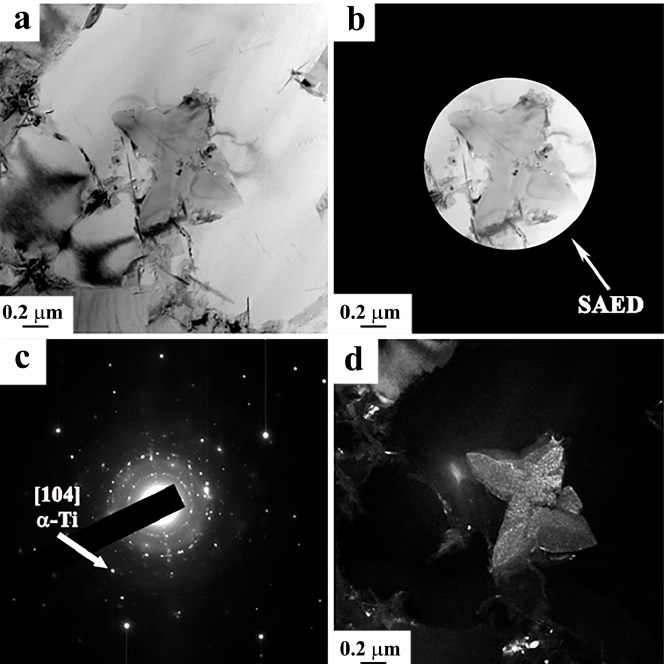
Figure 7. Electron microscopic image of Al-11wt%Si alloy’s surface layer structure subjected to electroexplosion alloying and subsequent irradiation by pulsed electron beam; a - bright fields and b - bright fields with SAED; c - selected area electron diffraction (the arrow designates the reflection of dark field formation); d - dark field formed in reflections [104] α-Ti